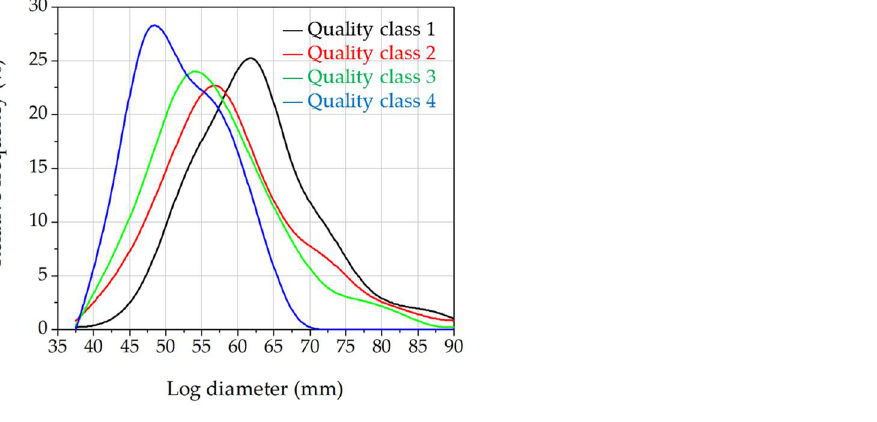
Table 2. Variation in number of tree rings in spruce logs of quality classes from Q 1 (highest) to Q 4 (lowest). St.dev—standard deviation; CoV—Coefficient of variation.